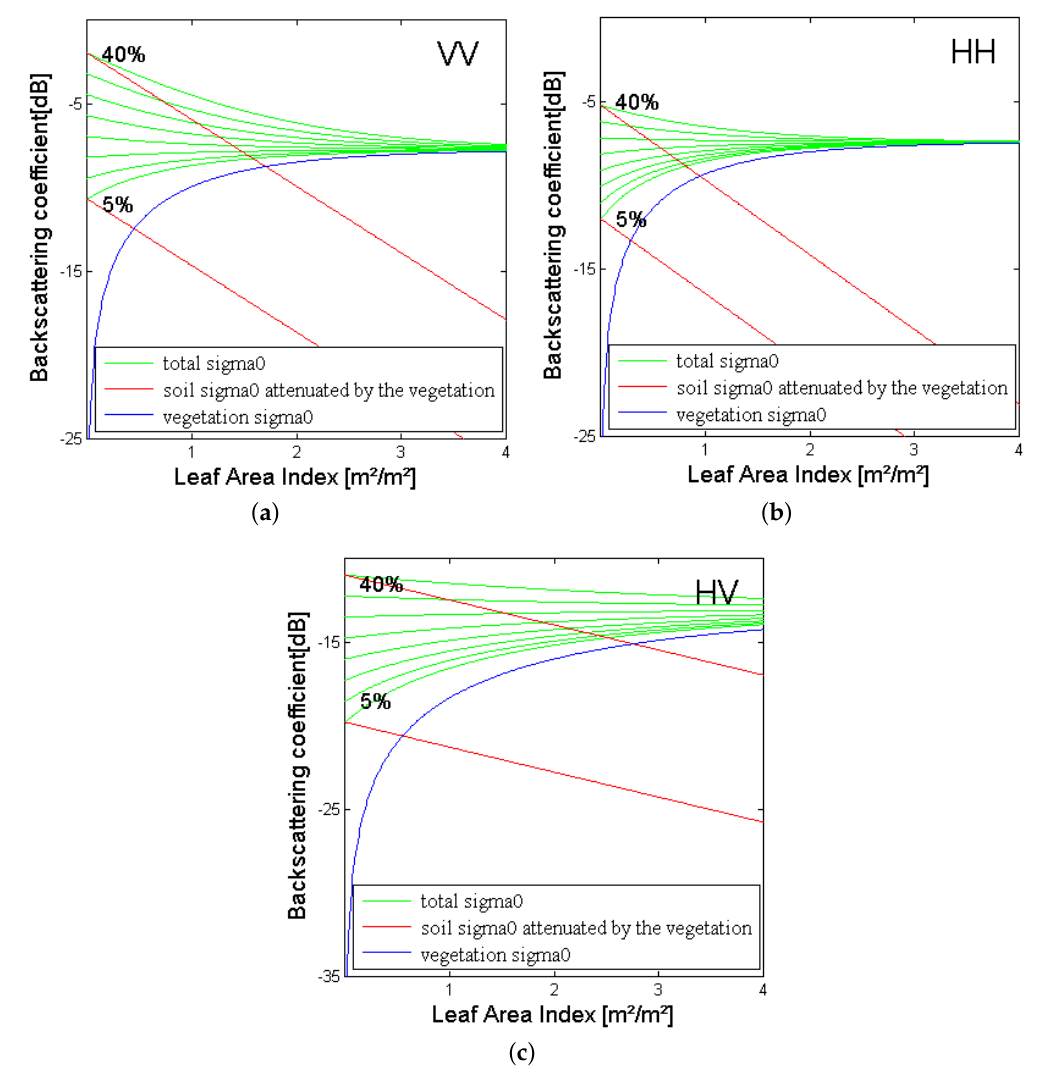
Figure 3. Backscattering coefficient simulation according to different soil moisture conditions and canopy statuses after WCM calibration for the VV ( a ), HH ( b ) and HV ( c ) polarizations. The green curves represent the total backscattering at different soil moisture values (from 5%–40% by steps of 5%). The red curve represents the backscattering coefficient from the soil attenuated by the vegetation for soil moisture of 5% and 40%. The blue curve represents the vegetation backscattering